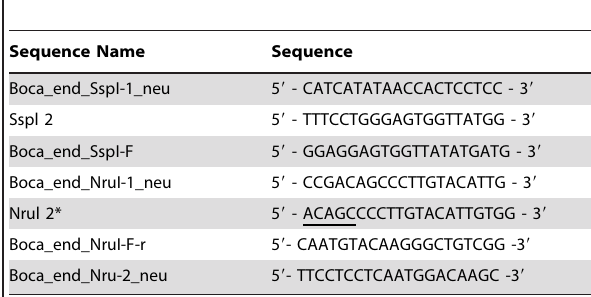
Table 1. Overview of alternative primers used in the study.